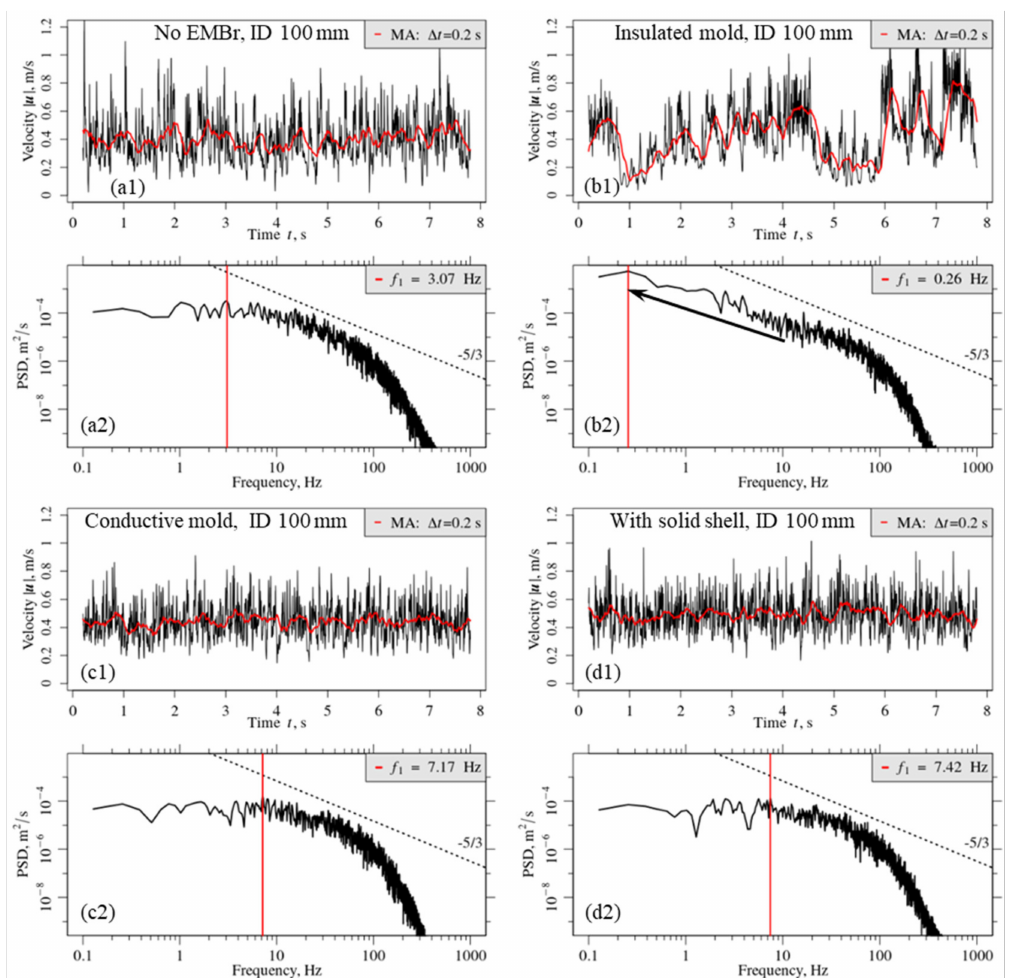
Figure 17. Instantaneous velocity at the monitor point P1 with moving average (top subfigures) and corresponding PSD (bottom subfigures), immersion depth (ID) of 100 mm: ( a1 , a2 ) Case 0A; ( b1 , b2 ) Case 1A; ( c1 , c2 ) Case 2A; ( d1 , d2 ) Case 3A. The PSD units are m 2 /s ∼ | u | 2 / f , where f is a frequency. The PSD is the flow